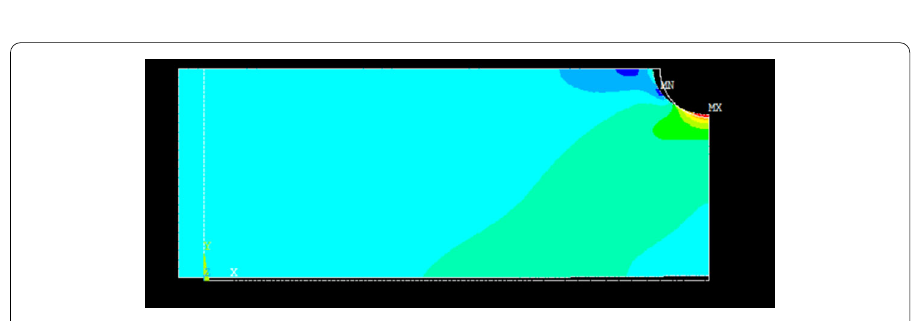
Fig. 9 Sample geometry notched plate. ( 1 sample problem